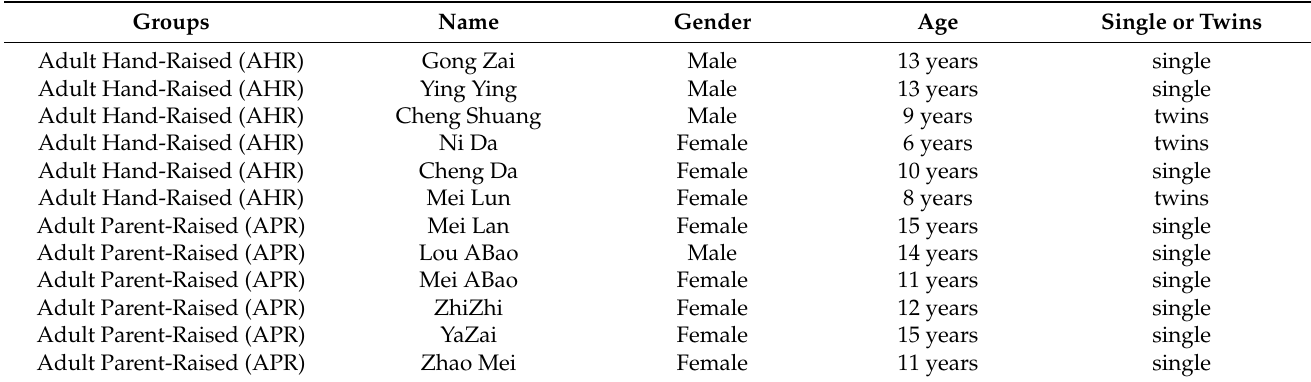
Table 1. Experimental